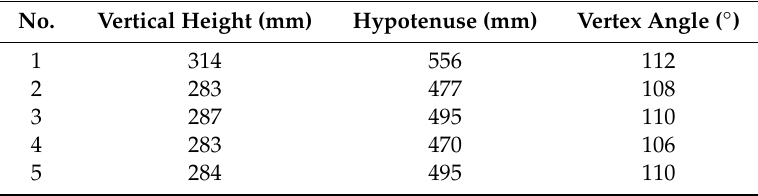
Table 3. Results of vertex angle of the pile of green cokes.